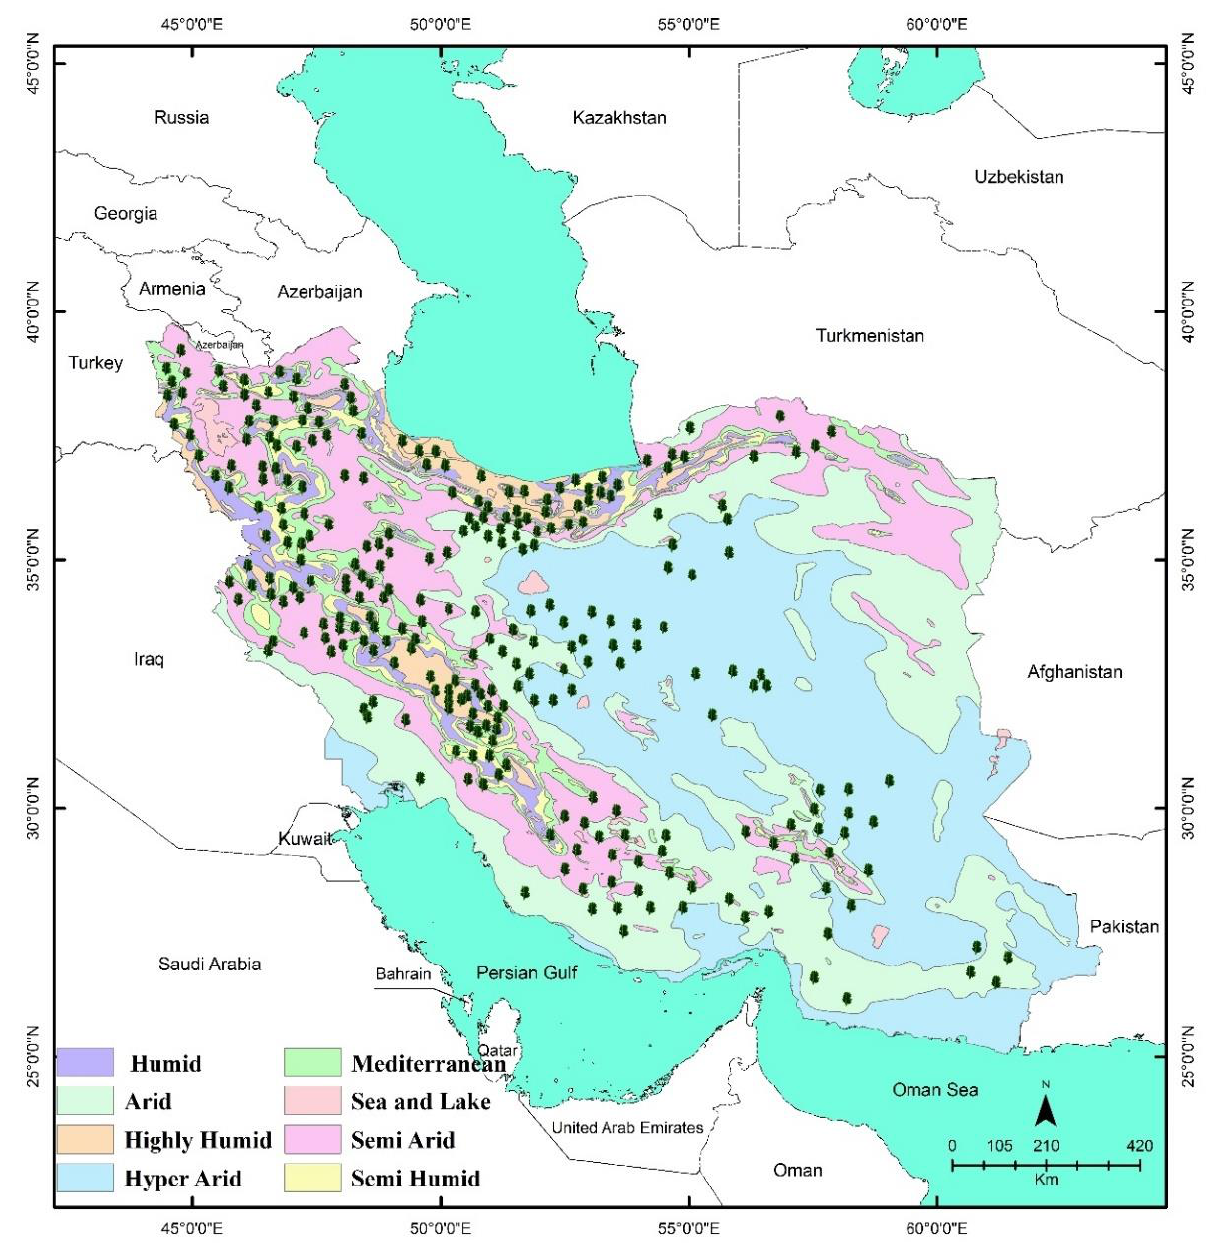
Figure 8. Climate map of Iran showing the location of endemic medicinal and aromatic plants.